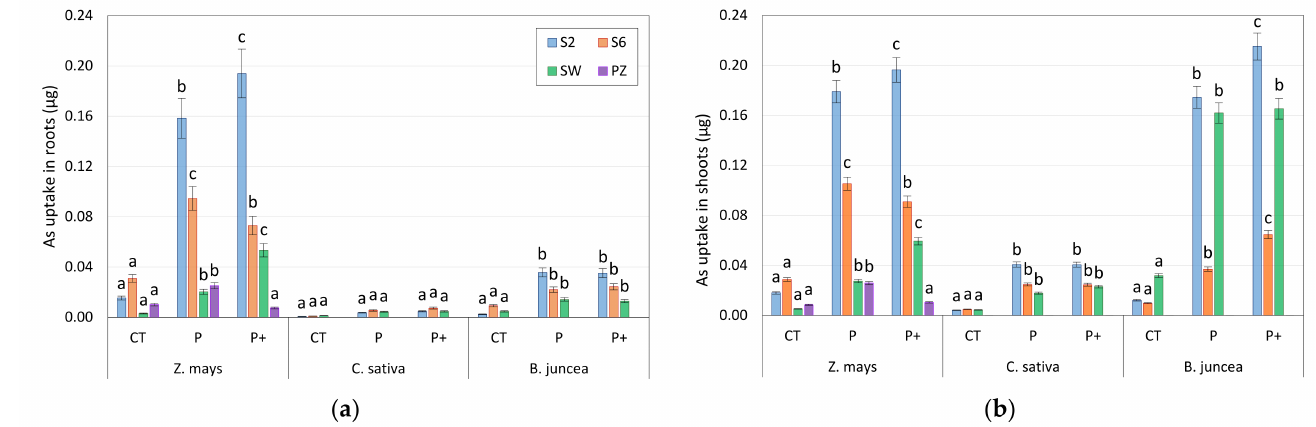
Figure 5. Arsenic uptake by ( a ) roots and ( b ) shoots of Z. mays, C. sativa, and B. juncea grown on soil control (CT) and As-contaminated soil treated with phosphate (P). The addition of PGPR bacteria (first set of isolates) is indicated with the “+” sign. Values are the mean of three replicates, and the error bars show the standard deviation. Values with different letters are significantly different at the 5% probability level (Tukey’s